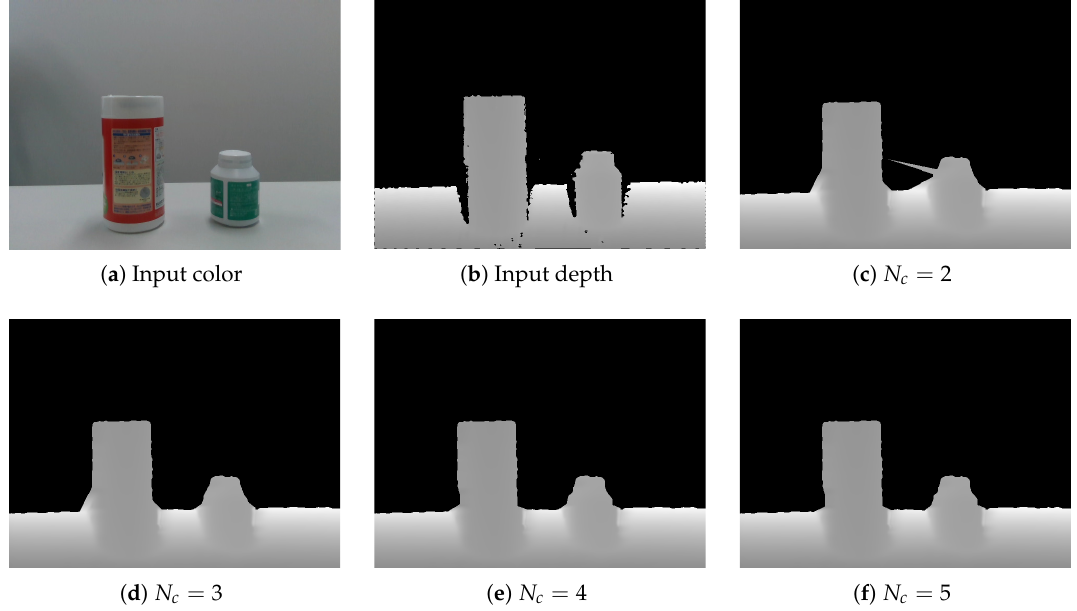
Figure 9. Results with the different N c . ( a ) Input color; ( b ) input depth; ( c ) N c = 2; ( d ) N c = 3; ( e ) N c = 4; ( f ) N c =